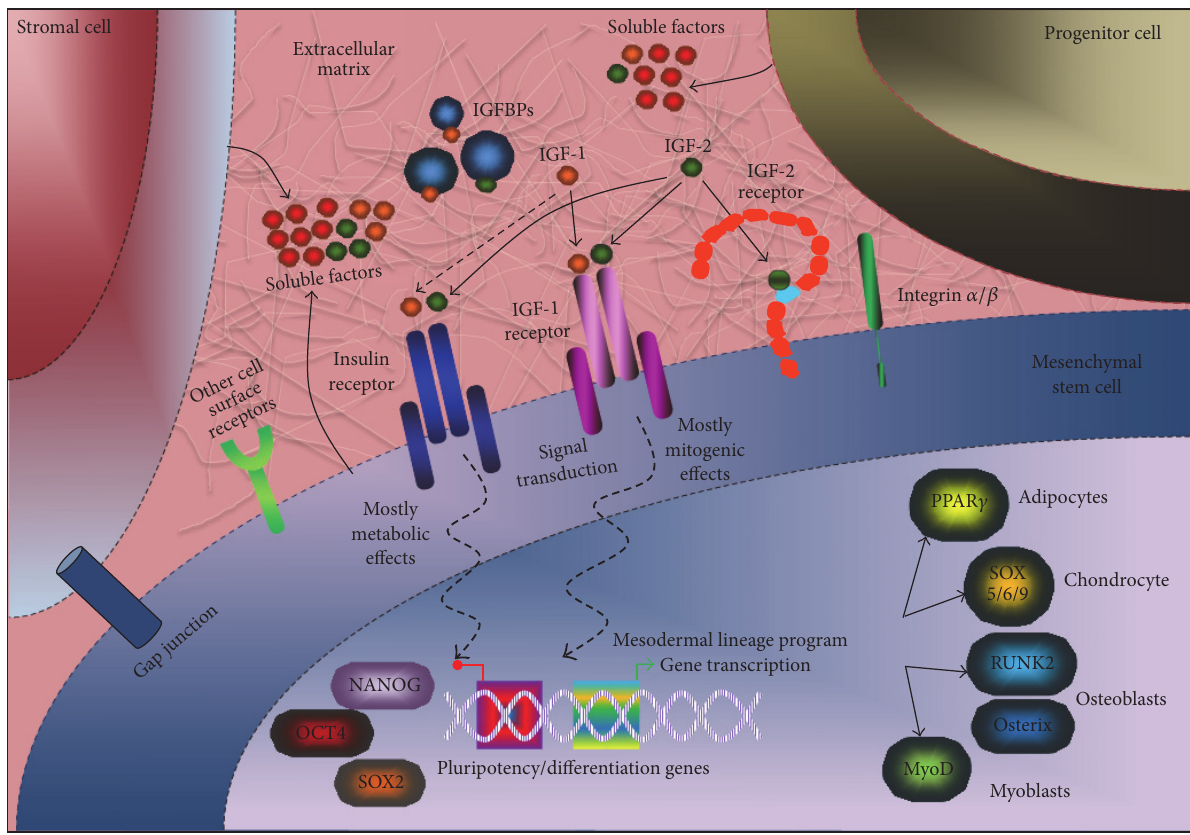
Figure 1: Stem cell niche in vivo. The stem cell niche is a complex compartment surrounding mesenchymal stem cells (MSCs) directing their identity preservation via cellular and acellular components. Various clues and signals are exchanged between MSCs, stromal cells, and progenitor cells and the extracellular matrix containing different soluble factors, oxygen tension, and pH. Therefore, MSC niche manipulates the stemness state of MSCs following growth and regeneration demand. IGFs can signal via paracrine/autocrine (produced locally by the tissue) or endocrine (delivered by blood supply) routes to interact with IGF-1 receptor, IGF-2 receptor, or the insulin receptor on MSCs and other cells. IGFBPs (extracellular and/or intracellular actions) can modify IGF actions and affect their stability and degradation. Other receptors and integrins are expressed in MSCs and can be affected by extracellular microenvironment. MSC differentiation occurs by signal transduction which controls the shutdown of pluripotency-associated genes, such as OCT4, SOX2, and NANOG, for the upregulation of differentiation genes. For example, MSCs can give rise to all mesodermal lineages depending on the transcription factor expressed to generate adipose, cartilage, bone, and muscle. Also, transdifferentiation of MSCs into endodermal and ectodermal lineages can occur, as reported by in vitro